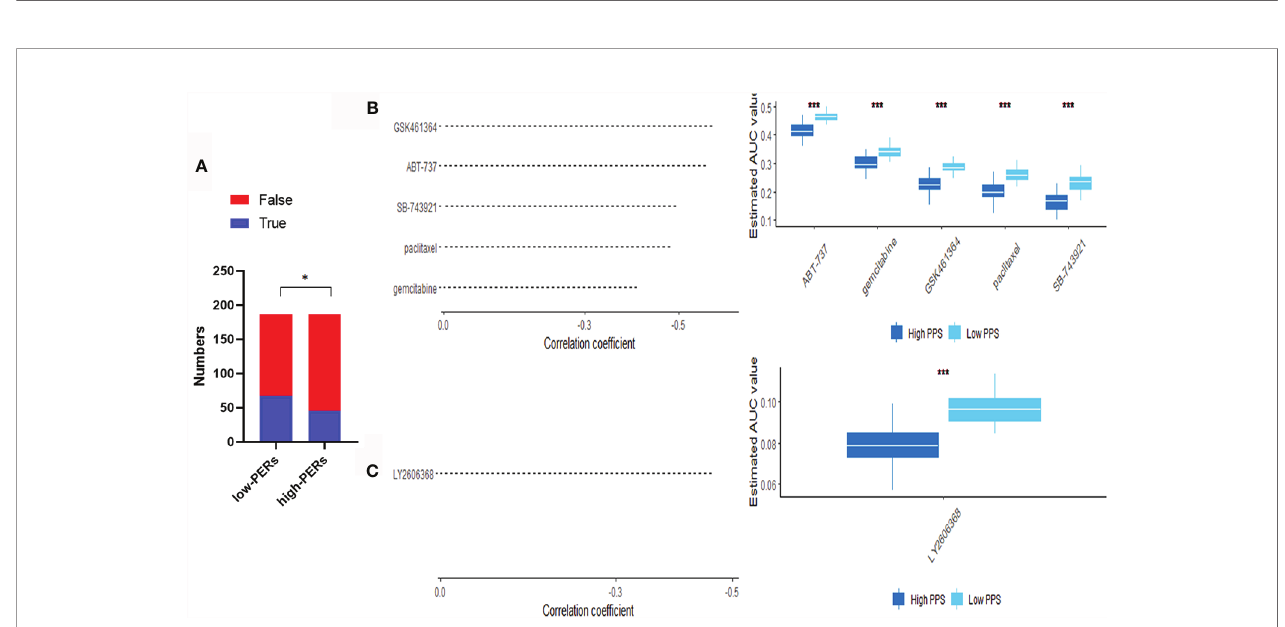
FIGURE 8 | Evaluation of drug effects. (A) The evaluation of immunotherapy based on the TIDE database. (B) The results of Spearman ’ s correlation analysis and differential drug response analysis of three CTRP-derived compounds. (C) The results of Spearman ’ s correlation analysis and differential drug response analysis of one PRISM-derived compounds. Note that lower values on the y-axis of boxplots represented greater drug sensitivity. *<0.05,